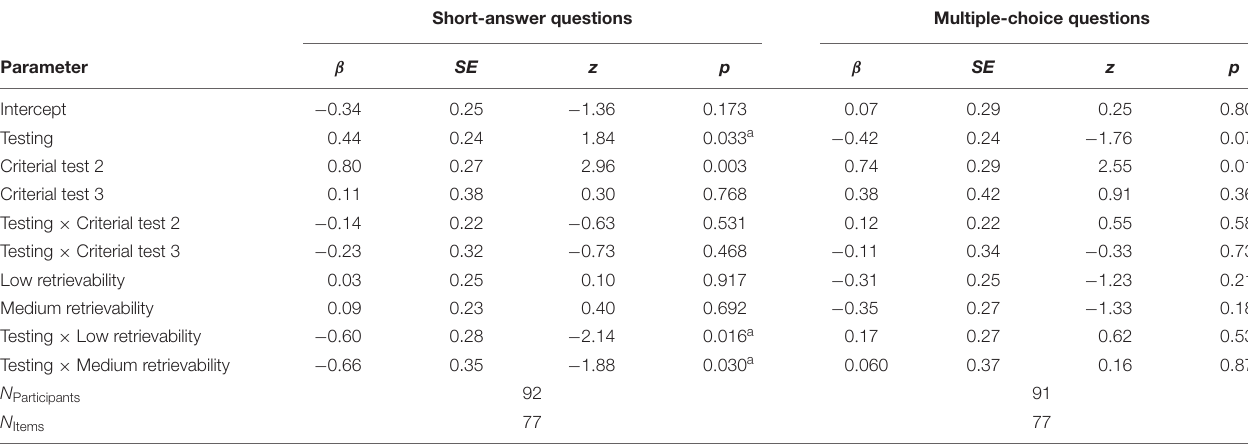
TABLE 2 | Parameter estimates for the models estimating the effect of testing with short-answer questions and multiple-choice questions, time of test, and retrievability on short-answer questions and multiple-choice questions on learning performance in the criterial